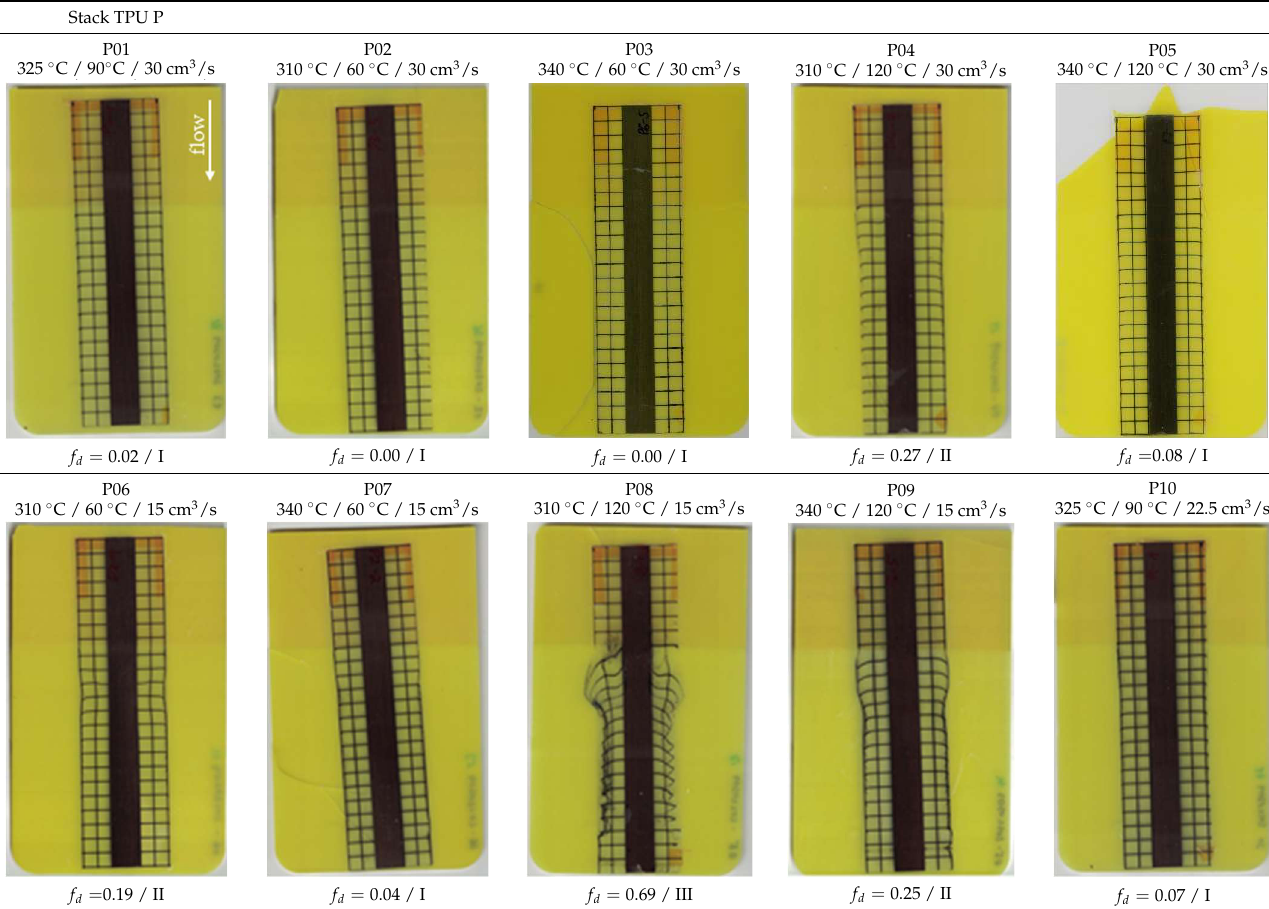
Table 3. Images of the overmolded films using TPU P for molding settings as outlined in Table 1. The associated distortion factor f d and damage category (I–III) are given below each image.